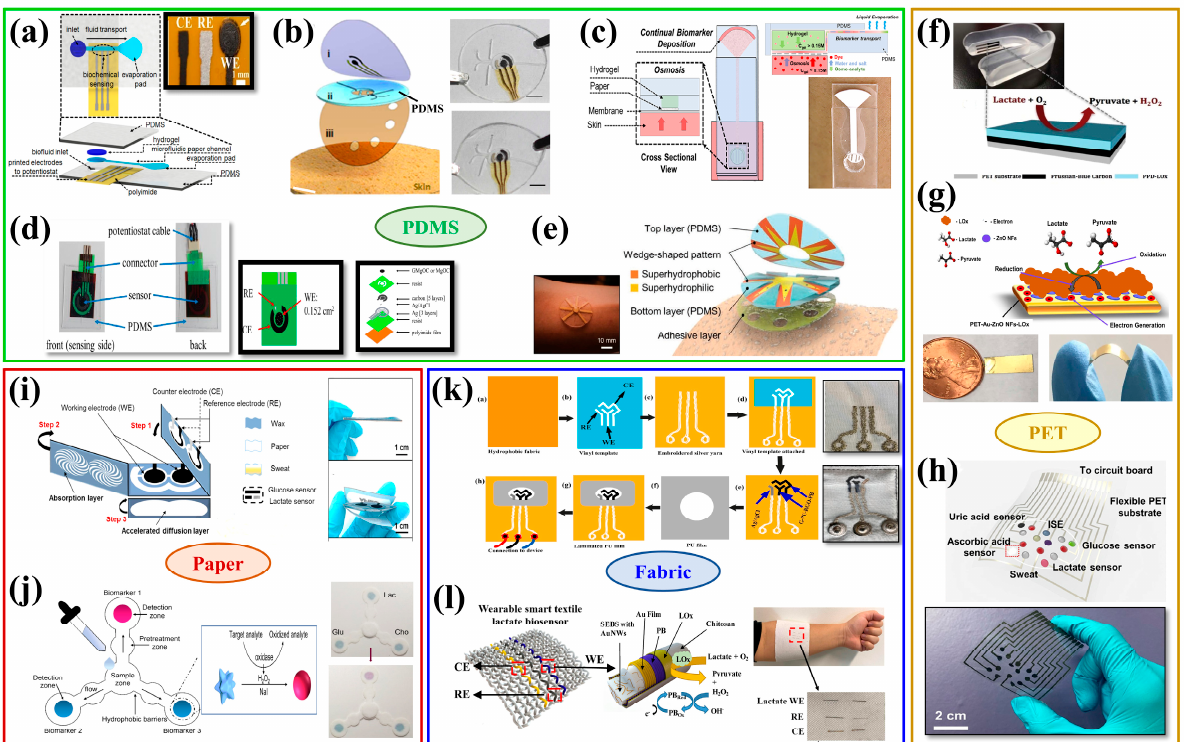
Figure 8. Biosensors for lactate detection based on different substrate materials: ( a – e ) Biosensors for detecting lactate based